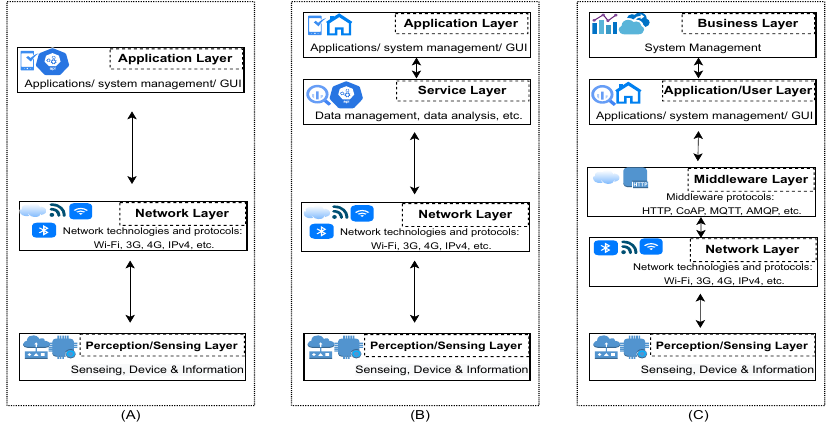
Figure 1. ( A ) Three-layer architecture [43,44], ( B ) four-layer architecture [45], ( C ) five-layer architec- ture